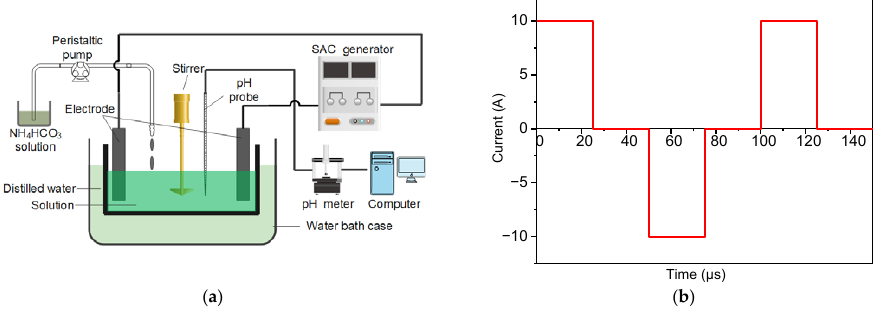
Figure 1. ( a ) Preparation process of yttria powders and ( b ) waveform of the applied current.